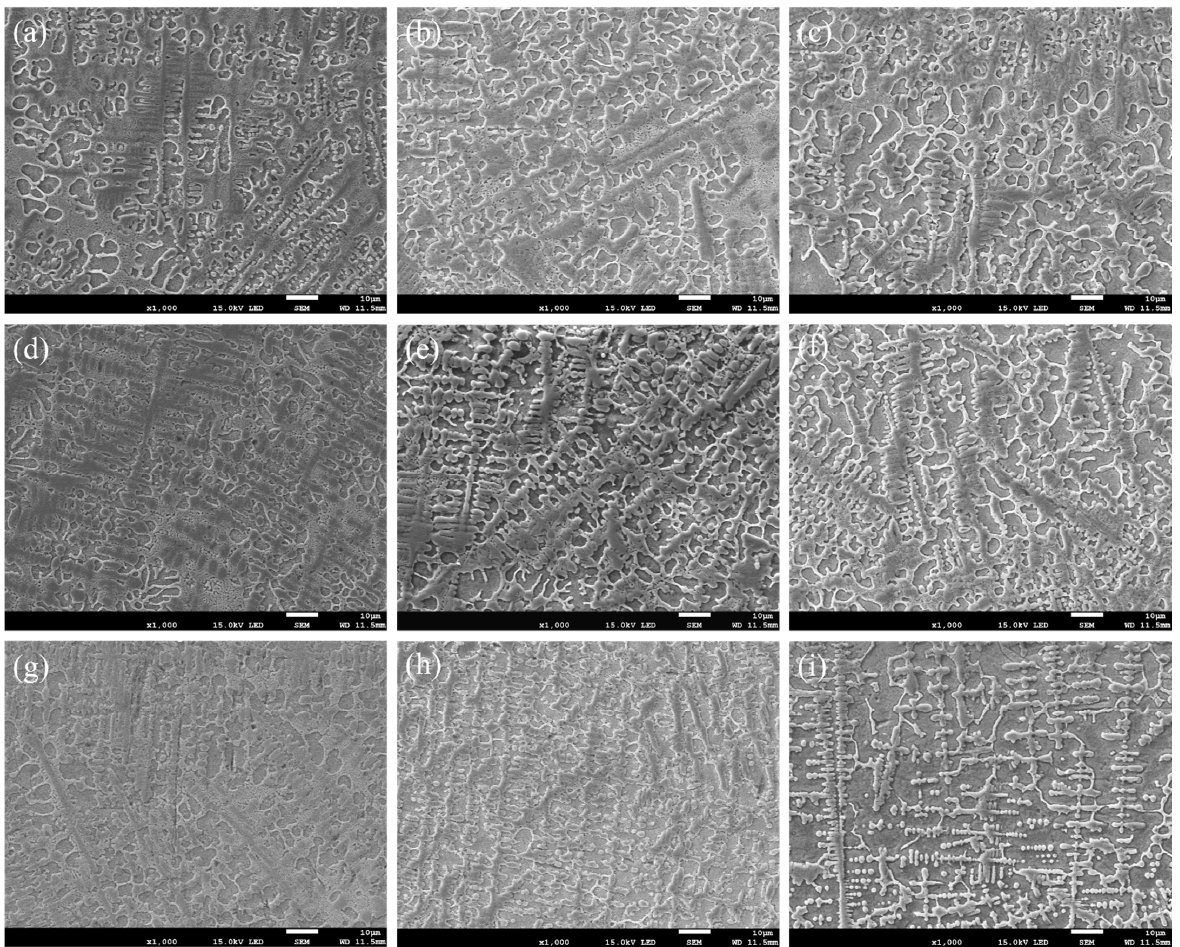
Figure 6. Morphologies of coatings: ( a – c ) the upper zone, ( d – f ) the medium zone, ( g – i ) the lower zone, ( a , d , g ) v = 12 mm/s, ( b , e , h ) v = 15 mm/s and ( c , f , i ) v = 18 mm/s.